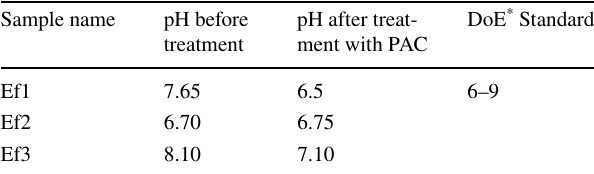
Table 1 pH of textile effluents before and after treatment Table 2 Electrical conductivity (EC) of textile effluents